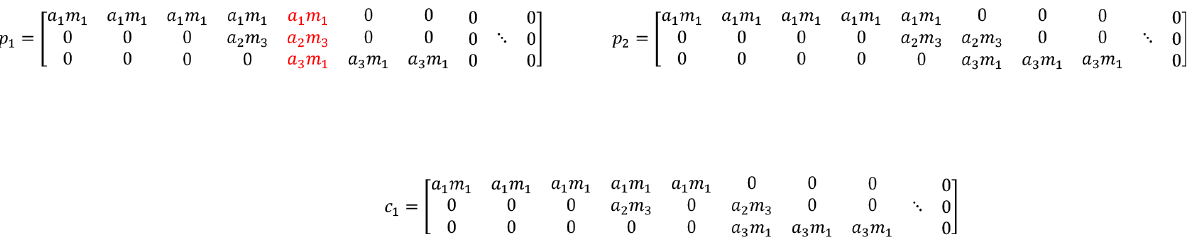
Figure 5. Sample of Crossover Operator’s